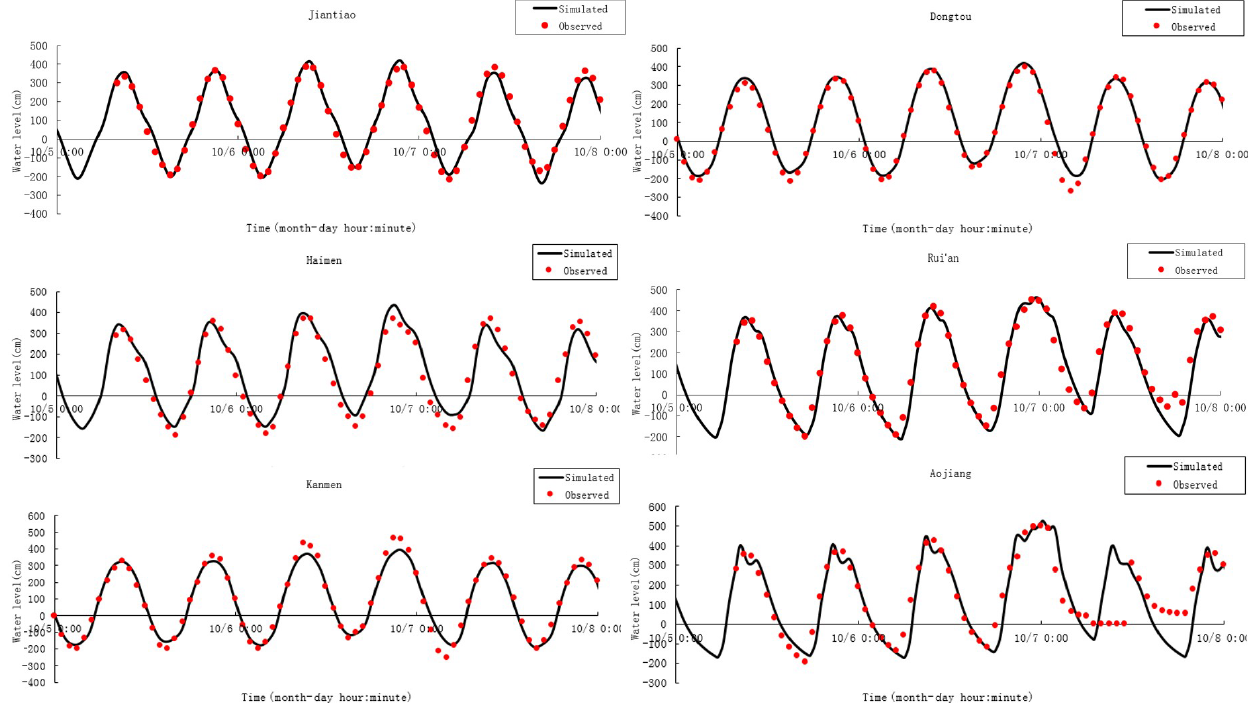
Figure 5. Verification of the high tide level for tidal stations affected by the storm surge caused by Typhoon Fitow (no. 1323).